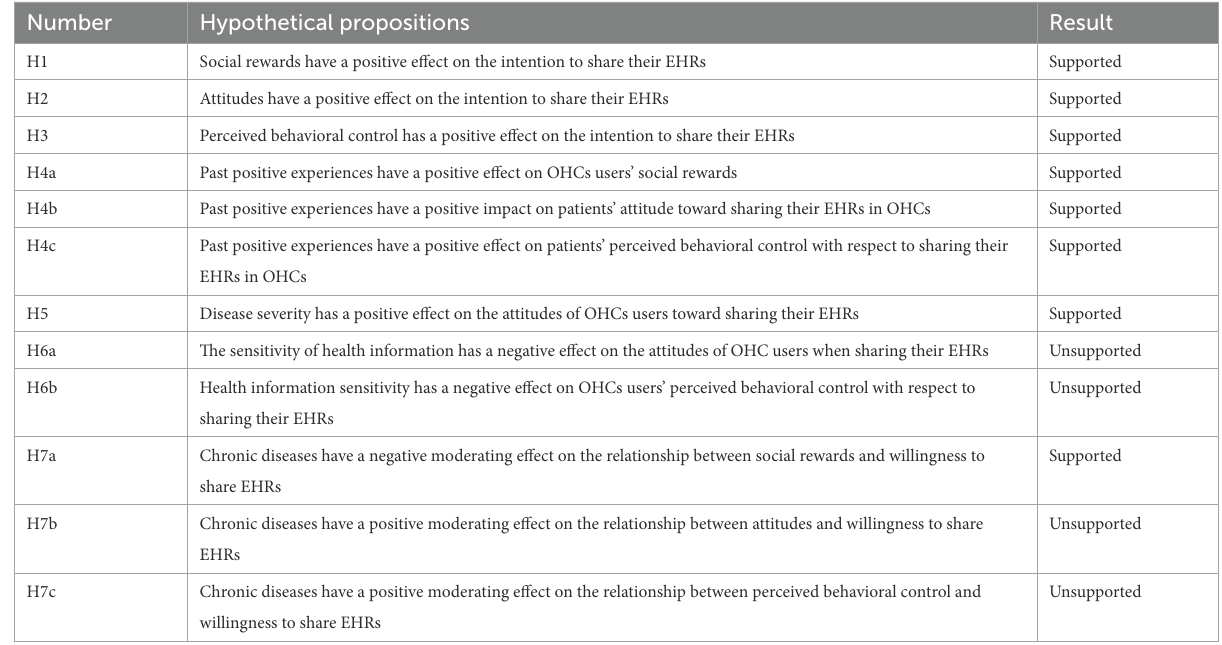
TABLE 5 Hypothesis validation results.